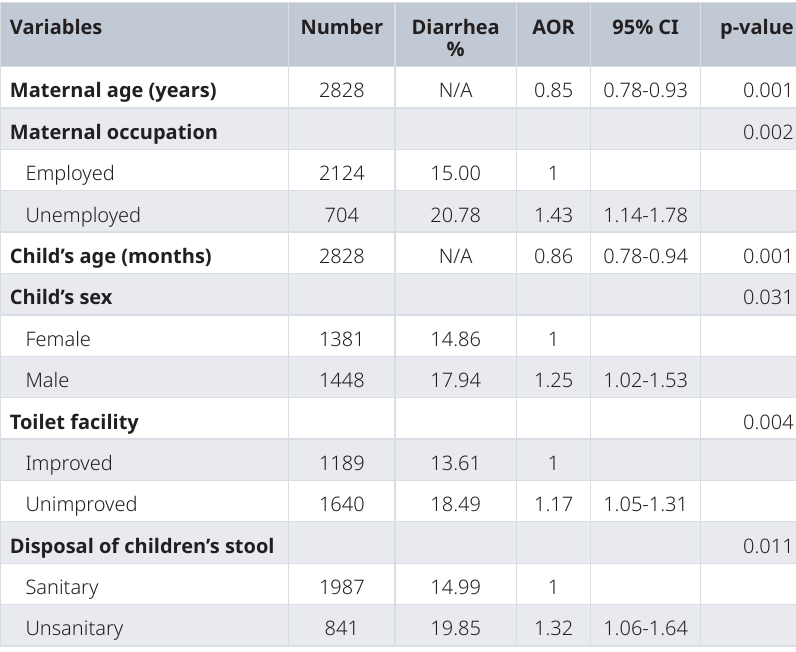
Table 5. Multivariable analysis of factors associated with childhood diarrhea in Cambodia, 2014 using generalized mixed linear model